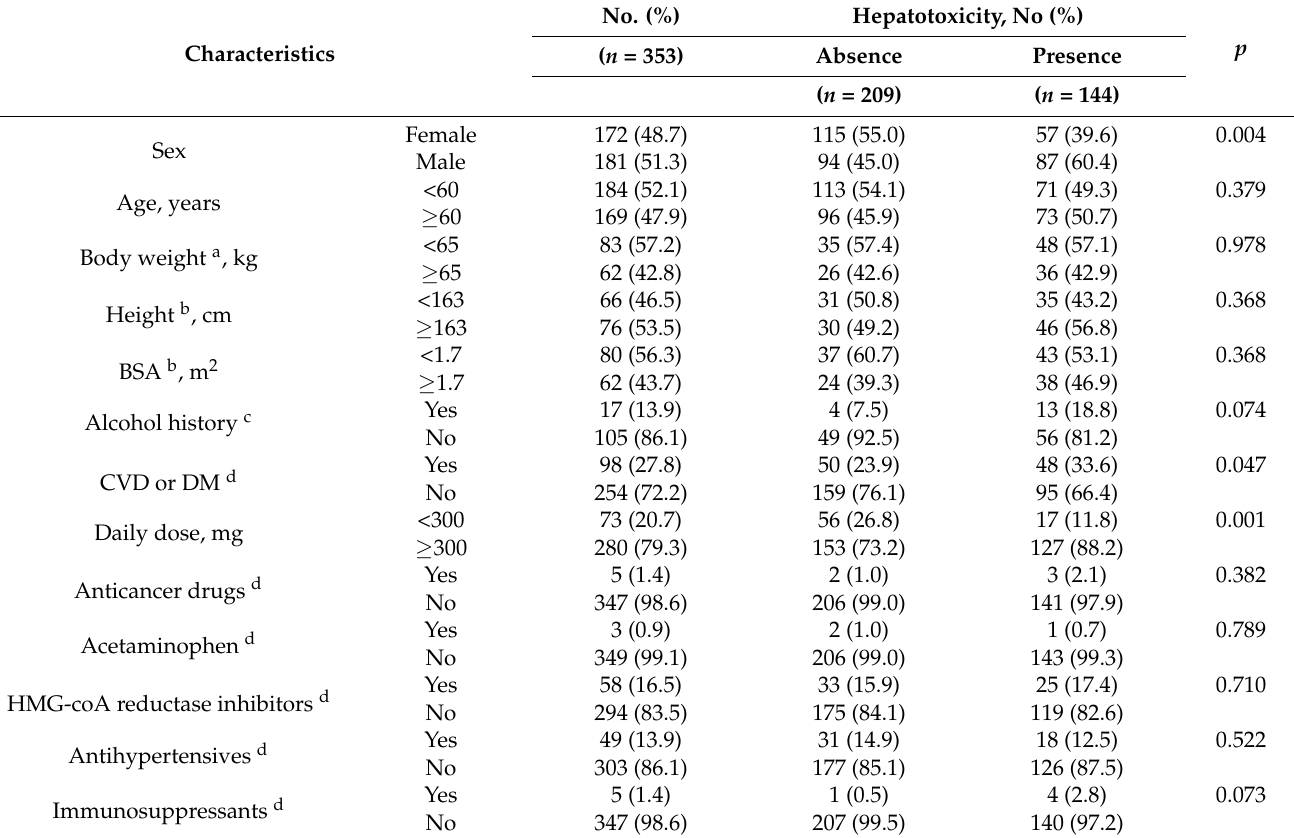
Table 1. Hepatotoxicity related to nilotinib